Question: Briefly state, in one sentence, what is plotted here.
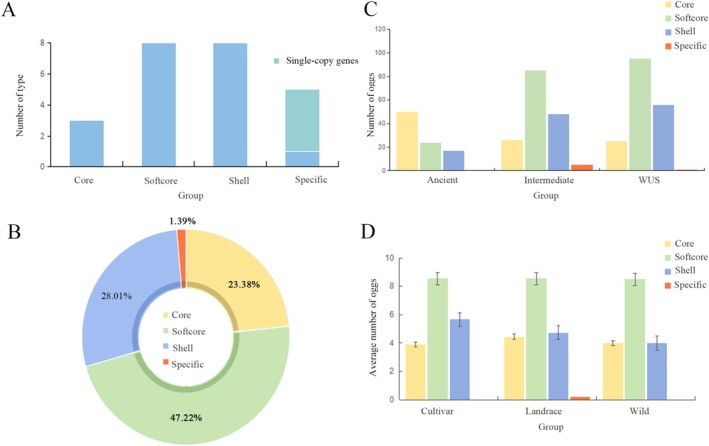
Answer: Number and Classification of WOX Genes in Alfalfa. (A) Number of OGGs of WOX in each component; (B) Percentage of each OGG gene; (C) The number of OGG genes in each clade; (D) Number of OGGs in different types.